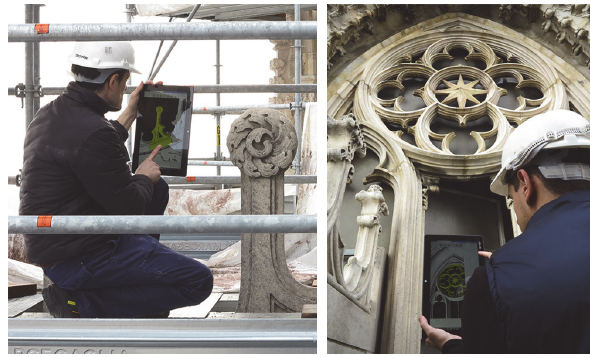
Figure 8. Use of BIM3DSG in the